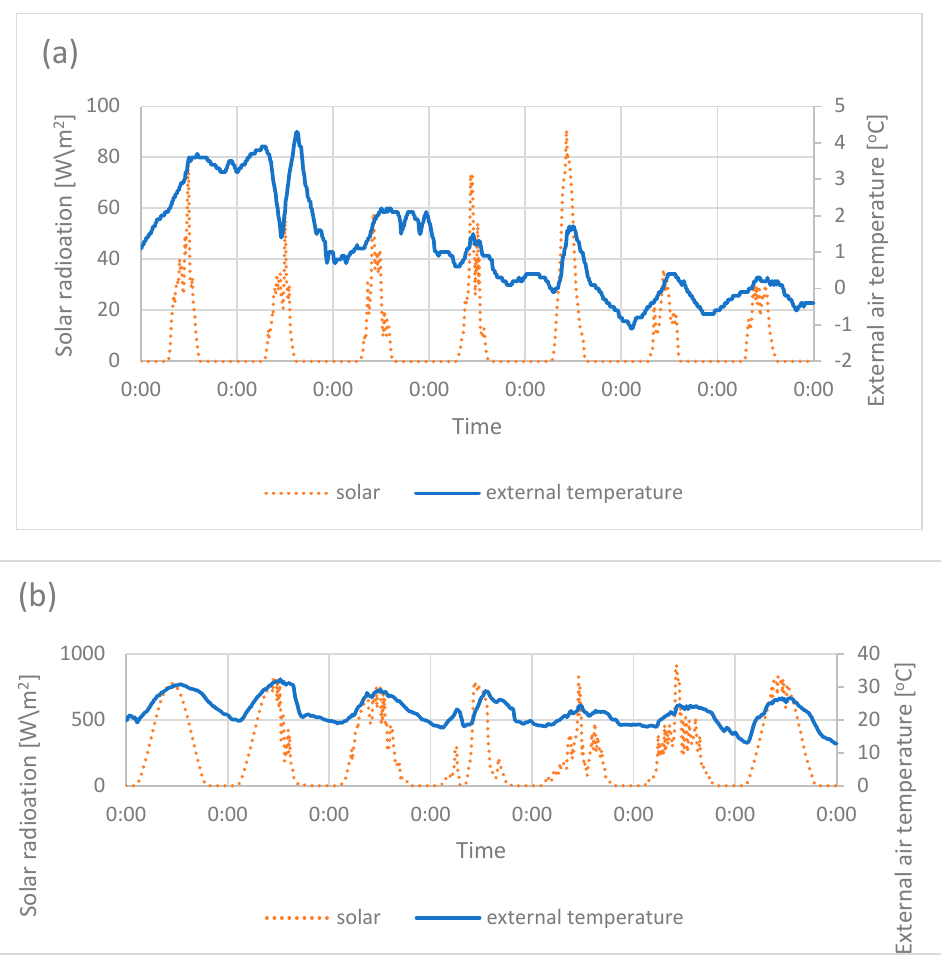
Figure 5. Air temperature and solar radiation on horizontal surface for ( a ) 4–10 January, ( b ) 21–27 June 2021 for Warsaw [30].